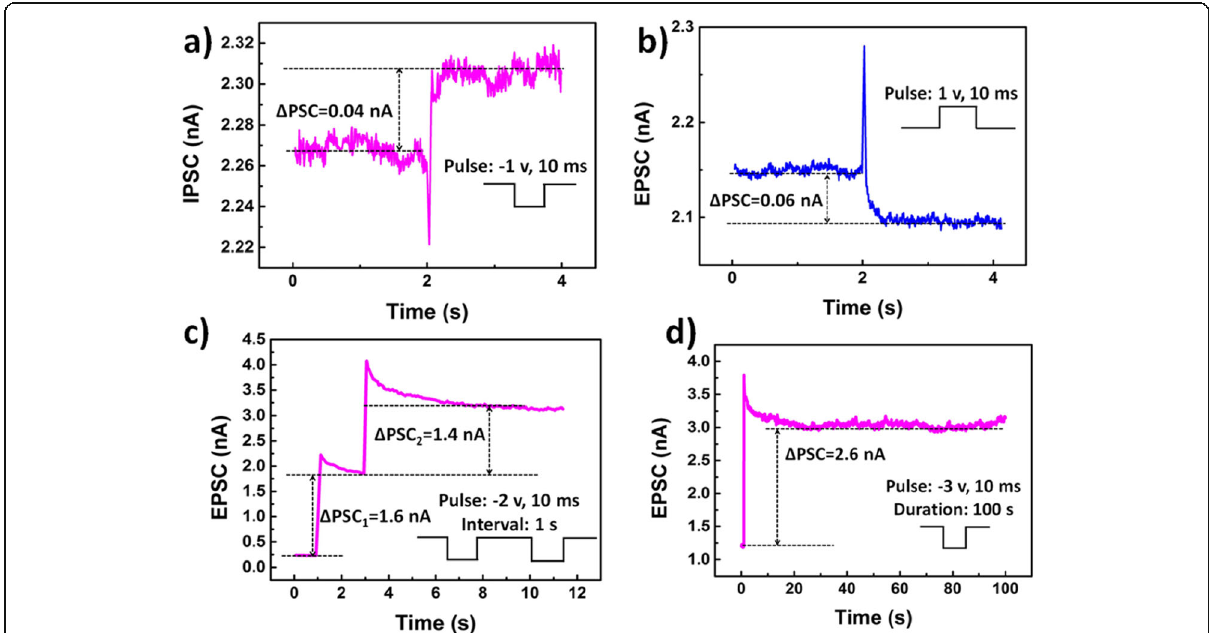
Fig. 3 Synaptic performance of the ReS 2 synaptic devices. a The excitatory postsynaptic current (EPSC) triggered by the input pulse ( − 1 V, 10 ms). b The inhibitory postsynaptic current (IPSC) triggered by a presynaptic spike (1 V, 10 ms). c Pair of output spikes of EPSC triggered by two consecutive input pulses ( − 2 V, 10 ms, and with a 1-s interval between pulses). d Retention characteristics of the ReS 2 synaptic devices after a − 3 V and 10 ms presynaptic